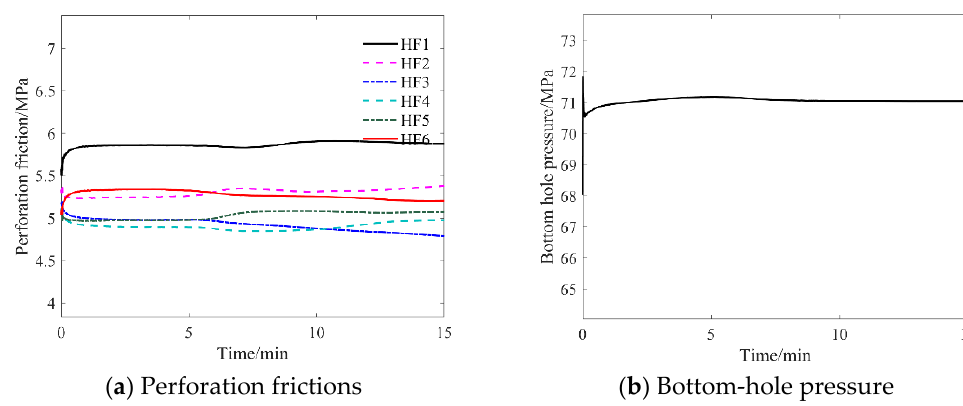
Figure 7. Perforation frictions and bottom-hole pressure of base case group.